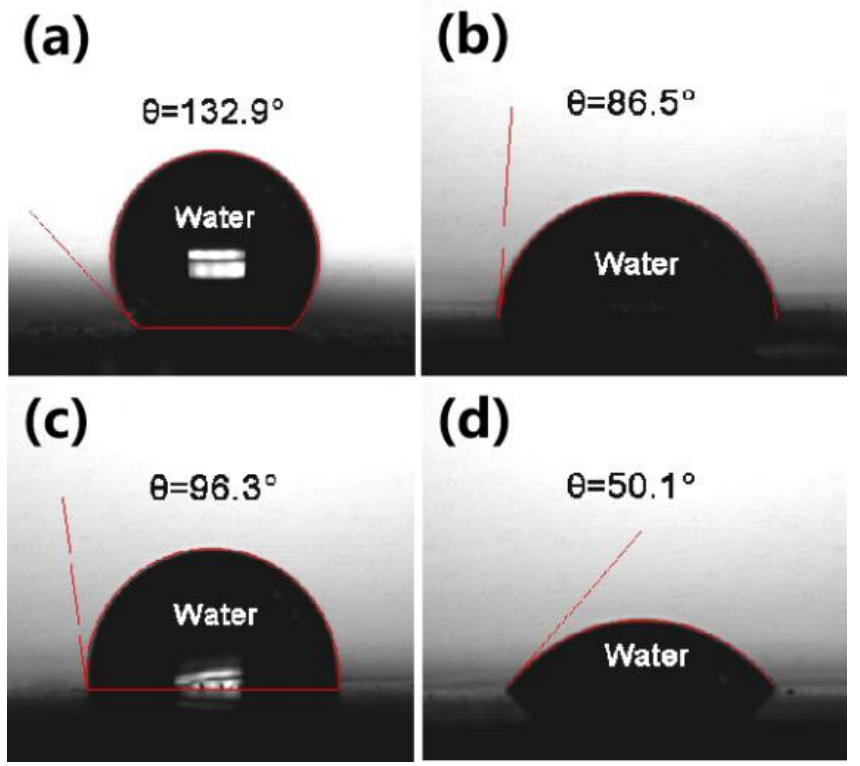
Figure 4. Contact angle of nanofiber membranes, F4 (CA-PtTFPP, ( a )), F5 (PCL-PtTFPP, ( b )), F1 (PCL&CA-PtTFPP, ( c )) and F3 (PCL&CA-PtTFPP/CS-FITC, ( d )).